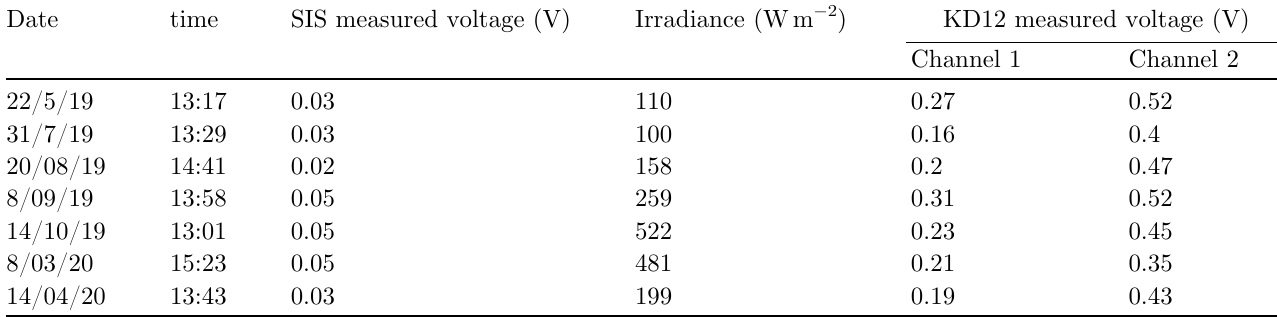
Table 3. Some examples of the measured voltage of the Solar Irradiance Sensor (SIS) installed close to the DSSC panel, with the corresponding irradiance values for those data. Registered data for KD12 are also included for comparison purposes.